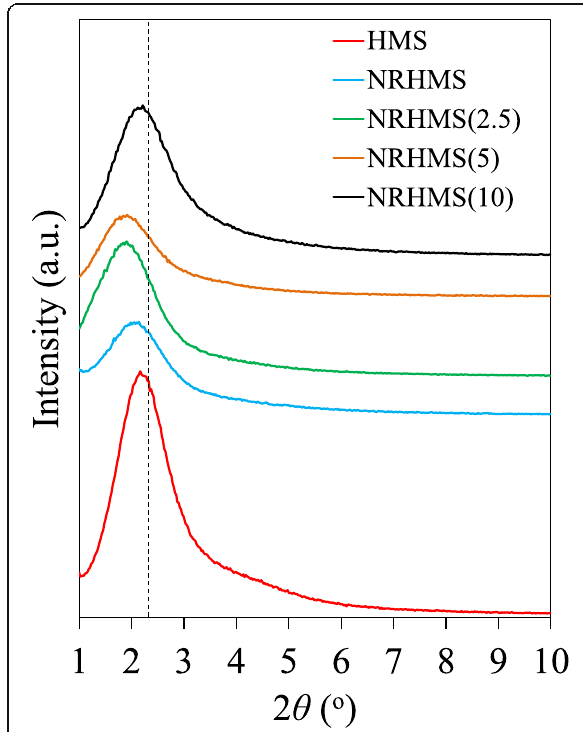
Fig. 2 Representative low-angle XRD patterns of HMS and the NRHMS